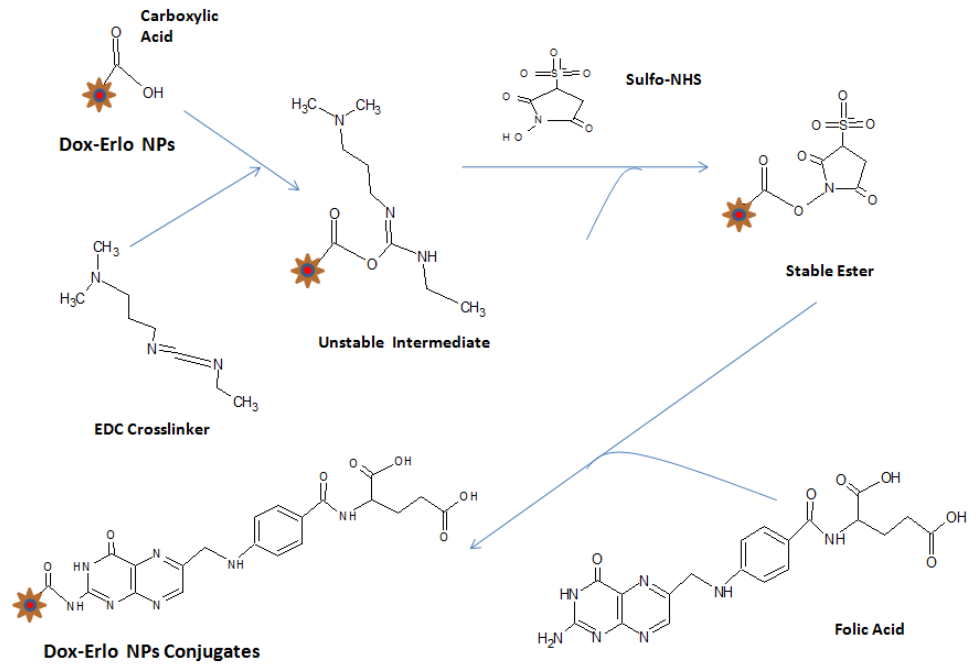
Figure 13. Surface modification of Dox–Erlo NPs.